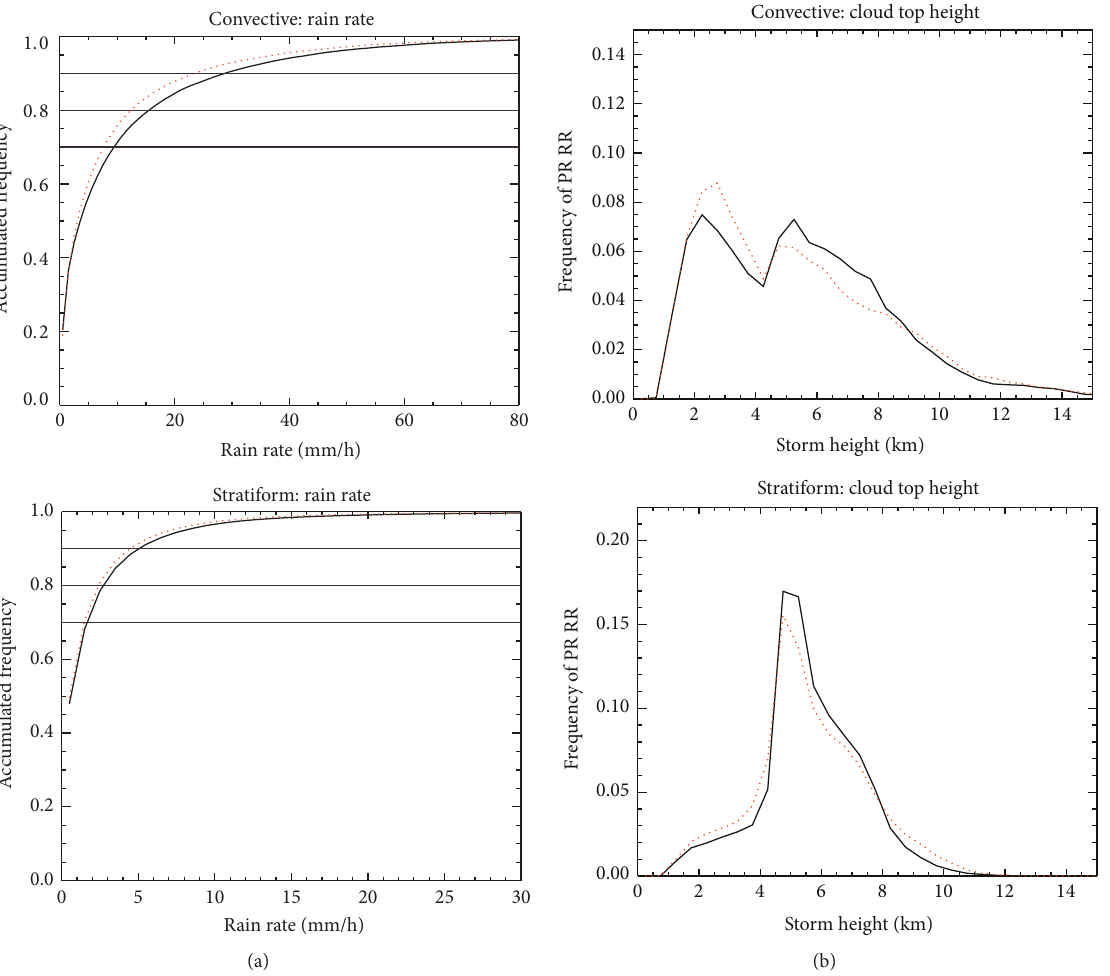
Figure 4: Accumulated frequency distribution of rain rate (a) and relative frequency distribution of cloud top height (b) for convective and stratiform rain clouds. Black and red lines represent Changma and post-Changma period,